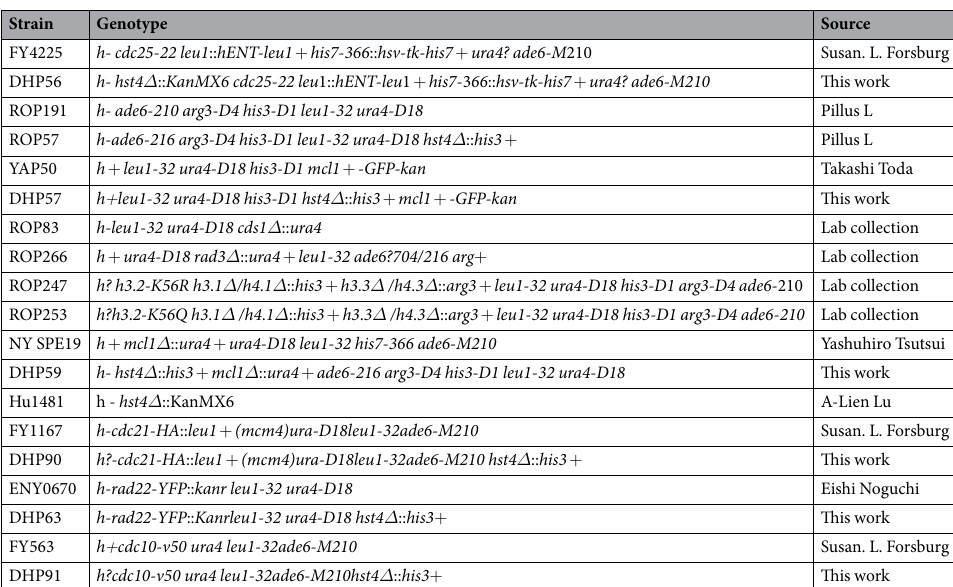
Table 1. List of strains used in the